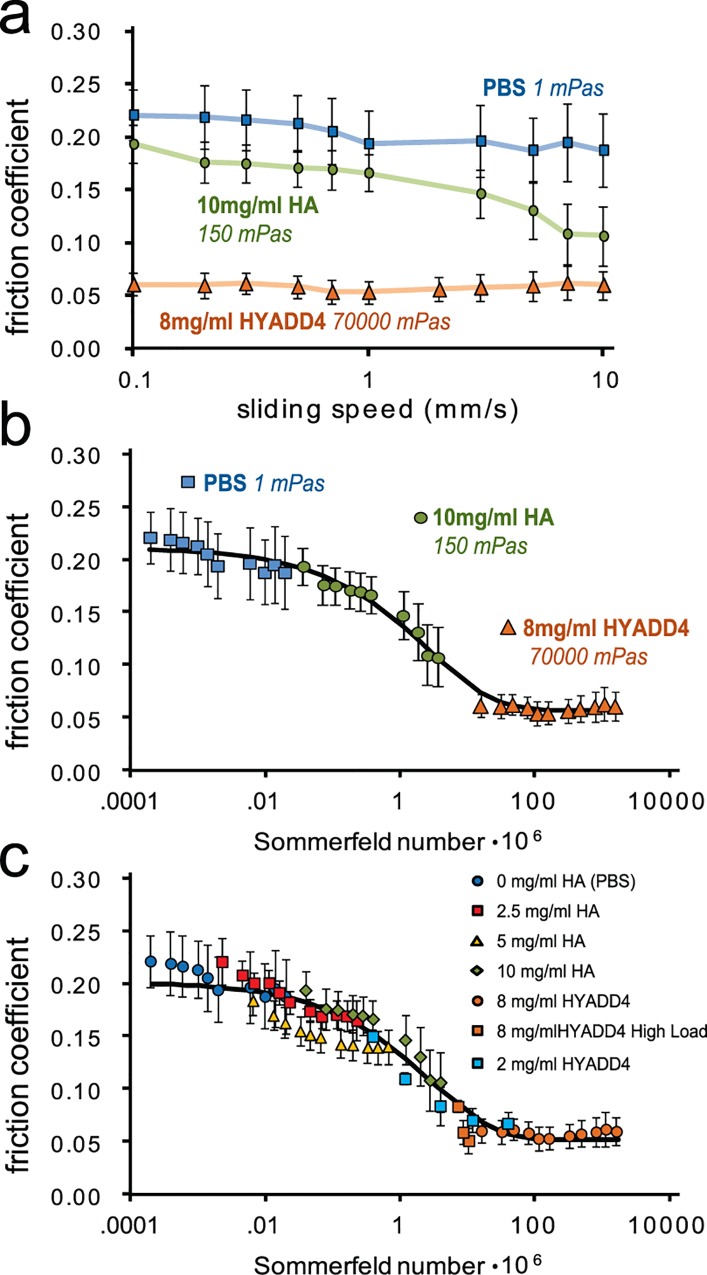
Presentation of friction coefficient as a function of the Sommerfeld number reveals viscous lubrication by HA.(Top) Friction coefficient as a function of sliding speed for three different lubricants with a wide range of viscosities provided a range of friction coefficients that span almost an order of magnitude (n = 5). (Middle) When the friction coefficients from the top panel are presented as a function of the Sommerfeld number (Eq 1) instead of sliding speed, the mechanisms of lubrication become apparent and are fit to a model curve (Eq 2) to determine alterations of the elastoviscous transition. (Bottom) Serial dilutions of the HA solution provided overlapping data sets confirming HA had no influence on the boundary friction coefficient, and increased load (4.2, 5.2, and 6.2 N; all at 0.1 mm/s) and decreased concentration (2 mg/ml) tests with HYADD4 revealed convergence of HA and HYADD4 in the transition region (HYADD4 2 mg/ml and high load, n = 4, all others n = 5) (data points represent mean±SEM).